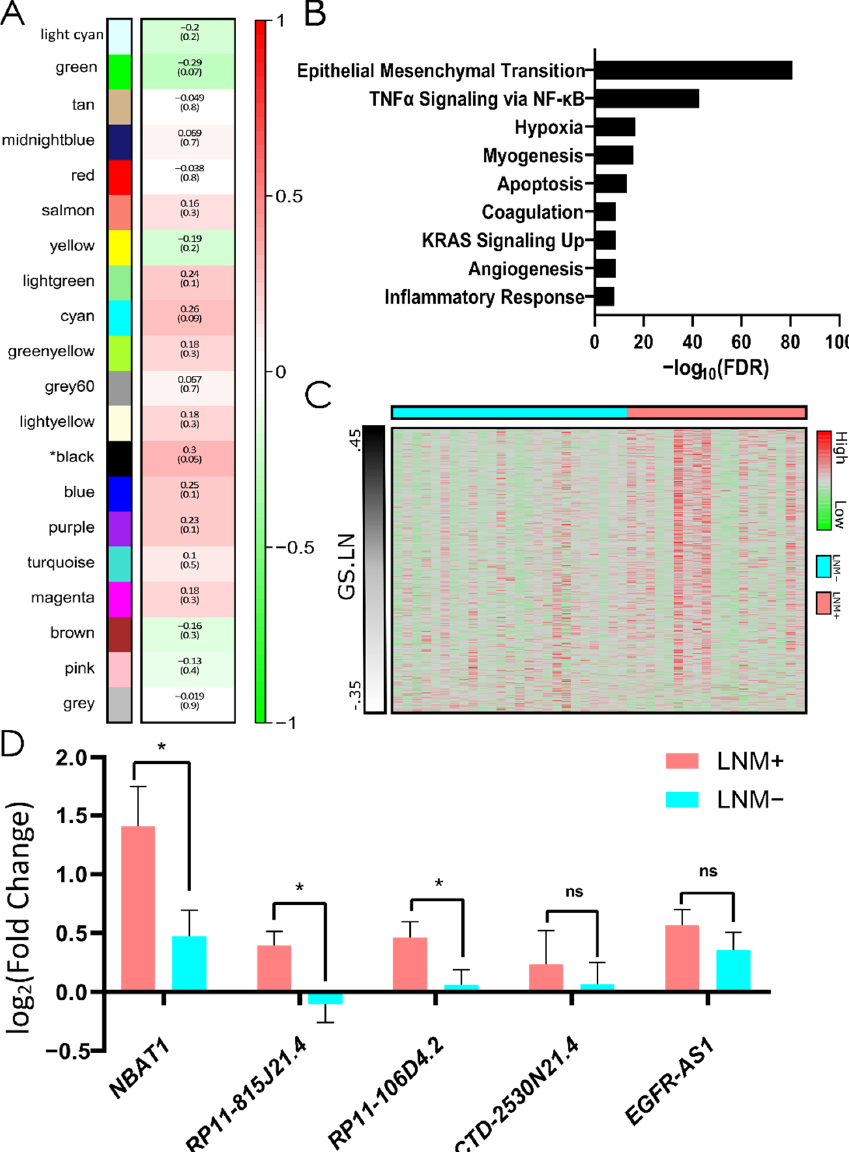
Figure 2. LNM-related co-expression analysis of PTC samples. ( A ) Relationship between WCGNA modules and LNM status. Values represent Pearson correlation coefficient and the correlation p -value (in brackets) between LNM and module eigengene. ( B ) Hallmark gene set analysis of the module most correlated with LNM status (black). ( C ) Black module constituent gene expression ranked by gene significance value related to lymph node metastasis (GS.LN) ( D ) Black module lncRNAs upregulated in LNM+ tissue but not LNM- tissue. LNM+ and LNM − , positive and negative lymph node status. * p < 0.05; ns, non-significant Table 2. Top 15 differentially expressed black module lncRNAs.